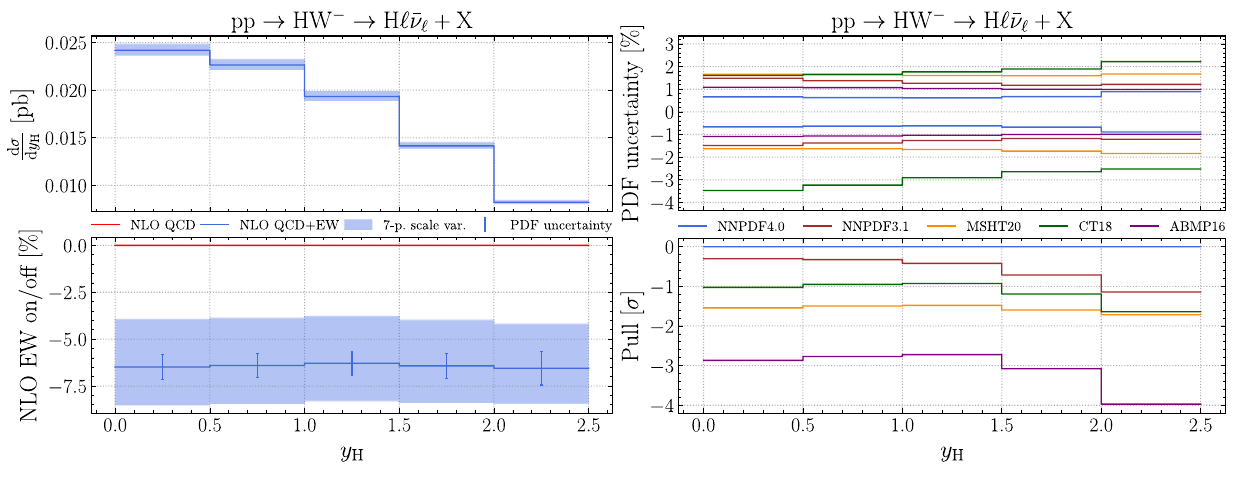
Fig. 71 Same as Fig. 63 for pp → H (cid:5) ¯ ν (cid:5) + X